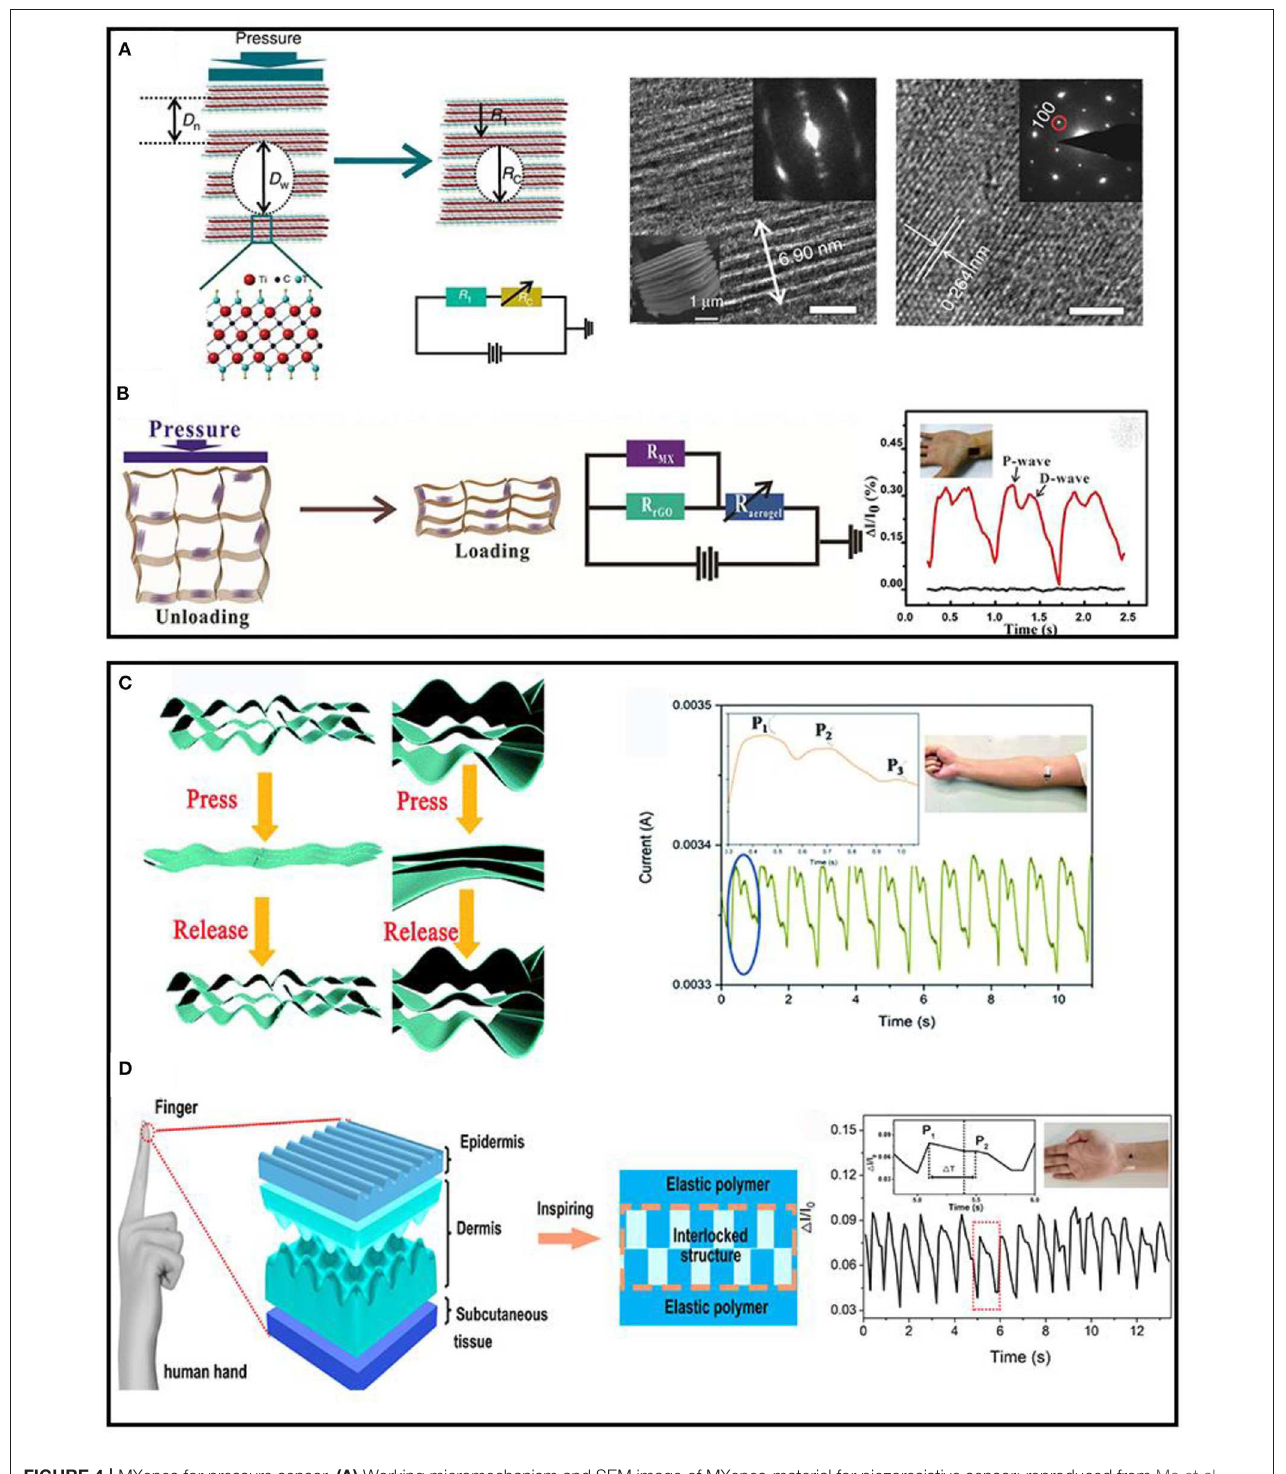
FIGURE 4 | MXenes for pressure sensor. (A) Working micromechanism and SEM image of MXenes-material for piezoresistive sensor; reproduced from Ma et al. (2017). (B) Schematic illustration and application of MX/rGO aerogel sensor; reproduced from Ma Y. et al. (2018) with permission from American Chemical Society. (C) Schematic elasticity mechanisms and application of C-MX/CNC; reproduced from Zhuo et al. (2019) with permission from The Royal Society of Chemistry. (D) Schematic of interlocking structure of simulated human skin and the application of pulse measurement; reproduced from Wang et al. (2019) with permission from American Chemical